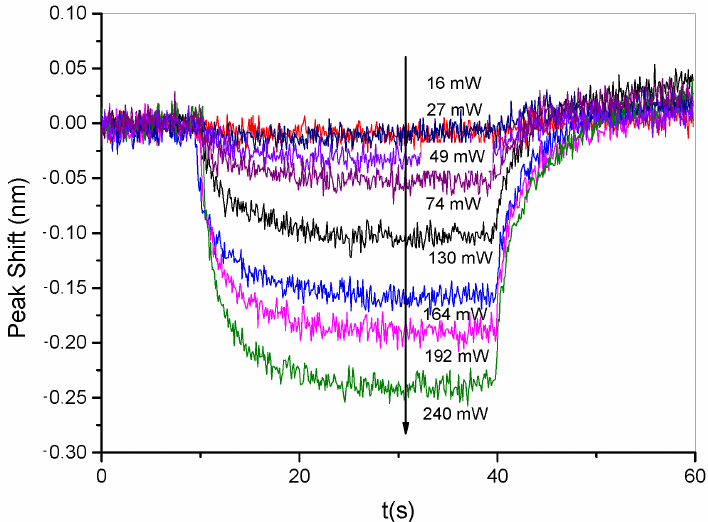
Figure 4. Peak shift of the recorded spectrum as a function of time for different irradiation power levels from 16 mW to 240 mW at λ = 457